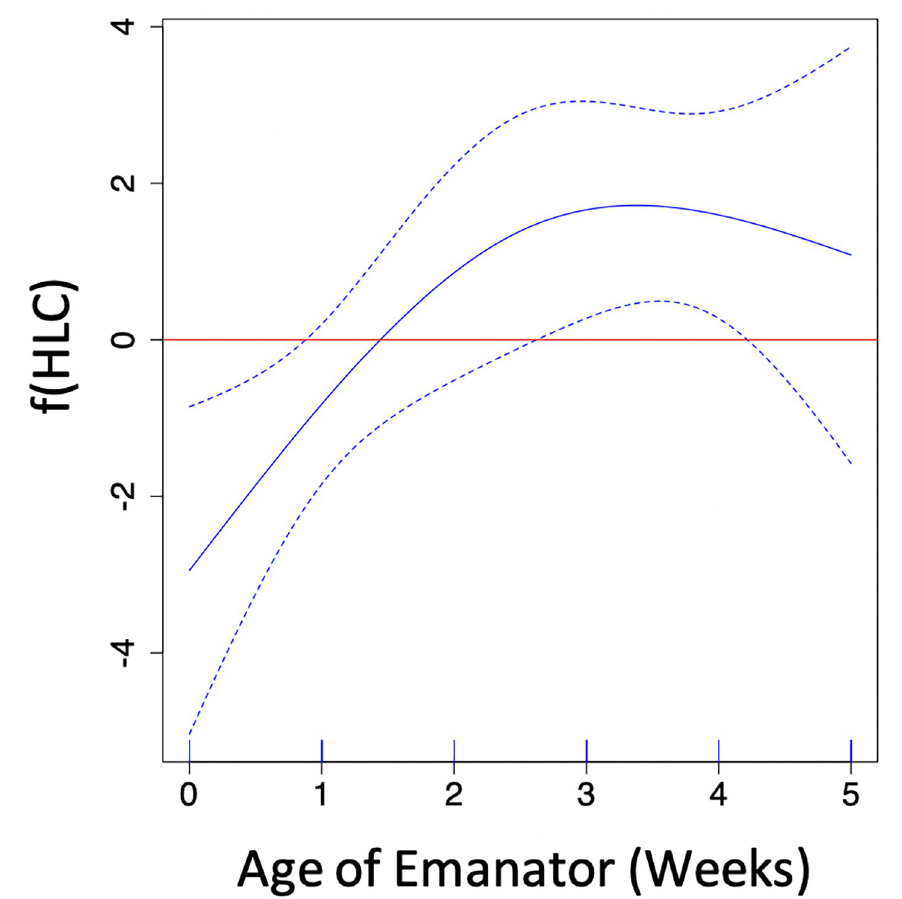
Fig 4. Modeling the impact of emanator age on HLC. General additive model results from the trial testing range of effect of metofluthrin emanators on Ae . albopictus landing counts ( f(HLC) ) indoors compared to a trial without emanator. The zero line shows the no-effect threshold and dotted lines the 95% confidence interval of f(HLC) . Anything above the line shows significant increase in HLCs compared to control, anything below the line shows the